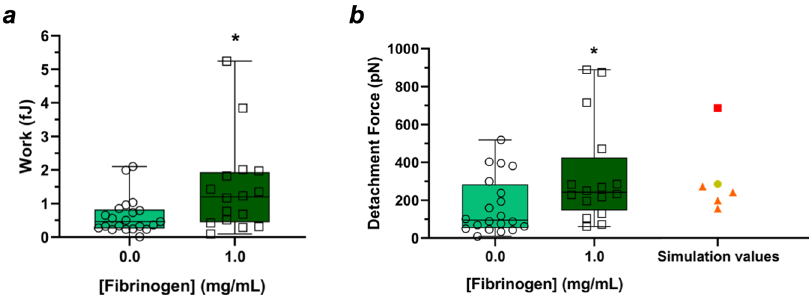
Fig. 3 AFM data of erythrocyte – erythrocyte detachment work and maximum detachment force. The work necessary to detach two erythrocytes in the presence of fi brinogen 1.0 mg/mL is higher than on its absence ( p = 0.030) ( a ). The maximum detachment force of two erythrocytes in the presence of fi brinogen is also higher ( p = 0.030) ( b ). For comparison, in b we also indicate the values of the erythrocyte – erythrocyte forces of our simulations. The yellow circle corresponds to the adhesion force between the cells in the simulation of Fig. 4 (below). The orange triangles indicate the adhesion forces between the cells in the simulations of Fig. 5 (below), for the different off-centred distances (1.02 μ m, 2.04 μ m, 3.06 μ m and 4.08 μ m). The red square depicts the adhesion force between the cells in the simulation of Fig. 6 (below). The experimental data refers to n = 28 biologically independent blood samples. For each blood sample approximately 40 force-distance curves were performed with and without fi brinogen addition. Experimental values are presented together with box-and-whiskers plots with the median value.